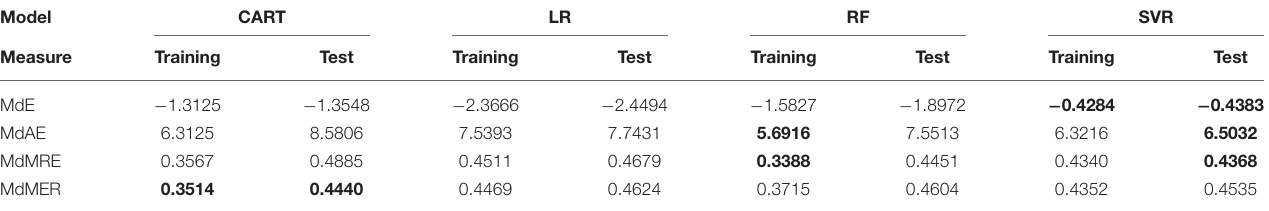
TABLE 6 | Performance evaluation results of count-part models (regression